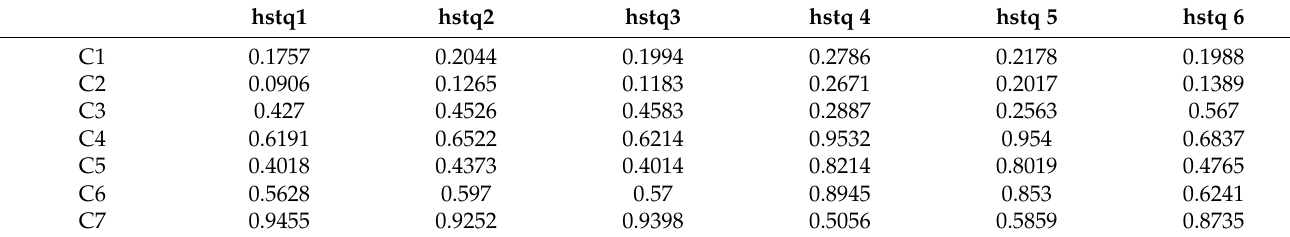
Table 6. Correlation coefficients between variables and the CC decision